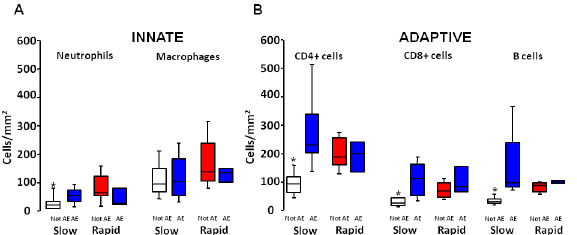
Fig 5. Differential inflammatory cells in slow and rapid progressors with and without acute exacerbation (AE). Number of innate inflammatory cells (neutrophils, macrophages) and adaptive inflammatory cells (CD4 + , CD8 + , and B lymphocytes) in the lungs of slow and rapid progressors; subjects who developed and those who did not develop AE are considered separately. Horizontal bars represent median values, bottom and top of each box plot 25 th and 75 th , brackets 10 th and 90 th percentiles. Slow not AE: white; rapid not AE: red; AE: blue. * P < 0.001 compared to slow who develop AE and rapid who do not develop AE